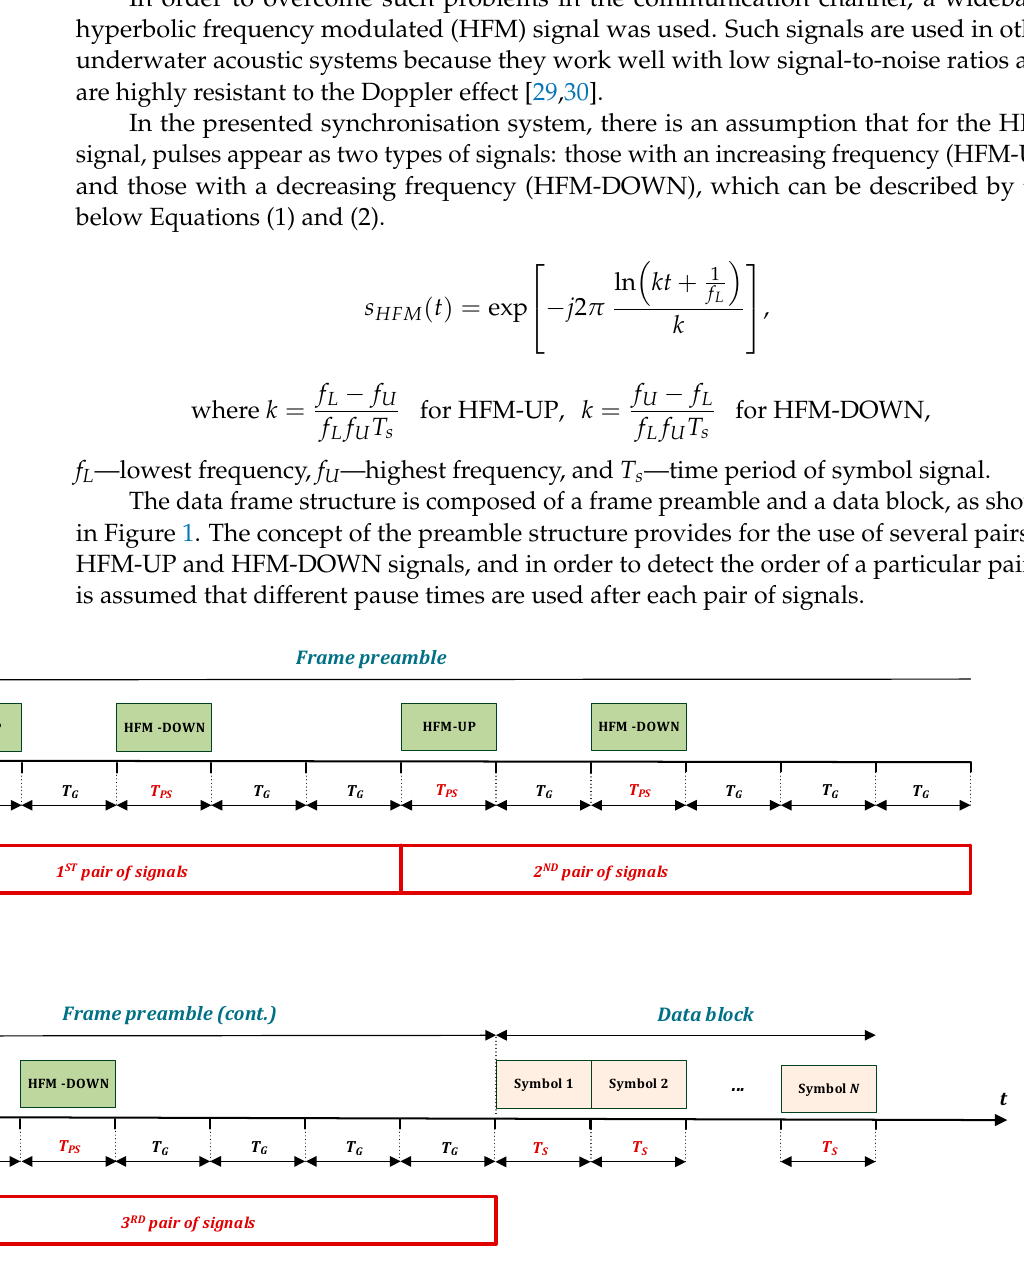
Figure 1. Data frame structure.